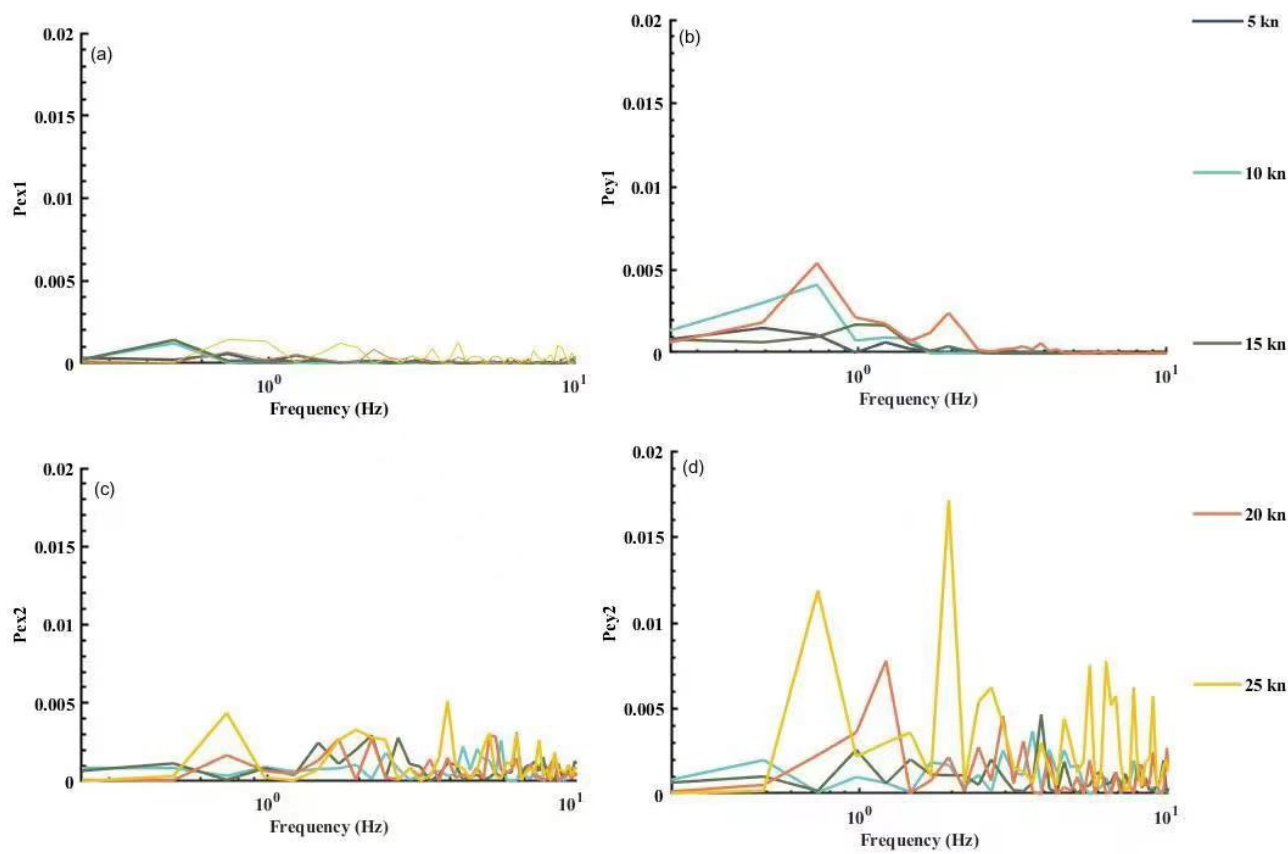
Figure 6. Noise power spectrum of the platform itself. ( a ) Power spectrum of the longitudinal component of the bow sensor; ( b ) Power spectrum of the transverse component of the bow sensor; ( c ) Power spectrum of the longitudinal component of the stern sensor; ( d ) Power spectrum of the transverse component of the stern sensor.